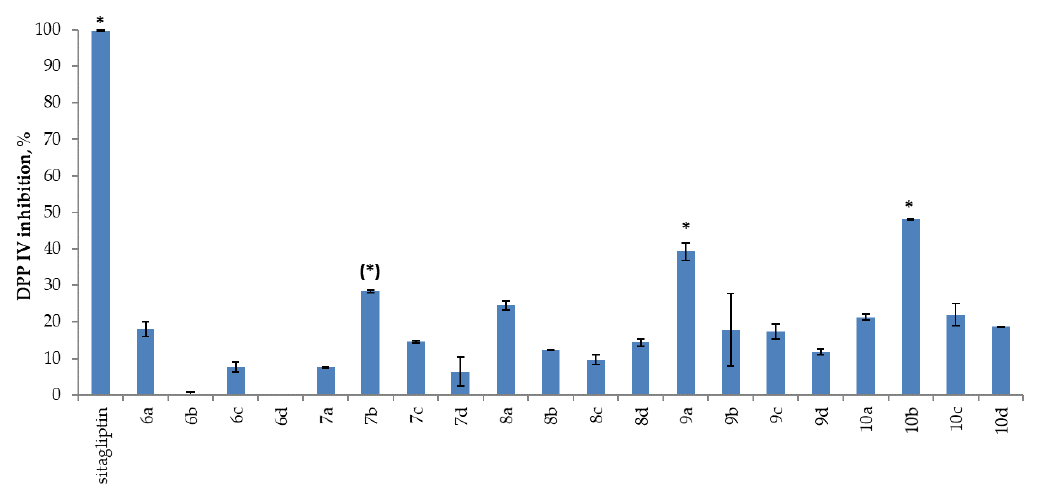
Figure 3. DPP IV inhibition (%) by all synthesized compounds at 100 μM. Measurements were performed in duplicate. * p < 0.05, (*) 0.05 < p < 0.1 as compared to control.